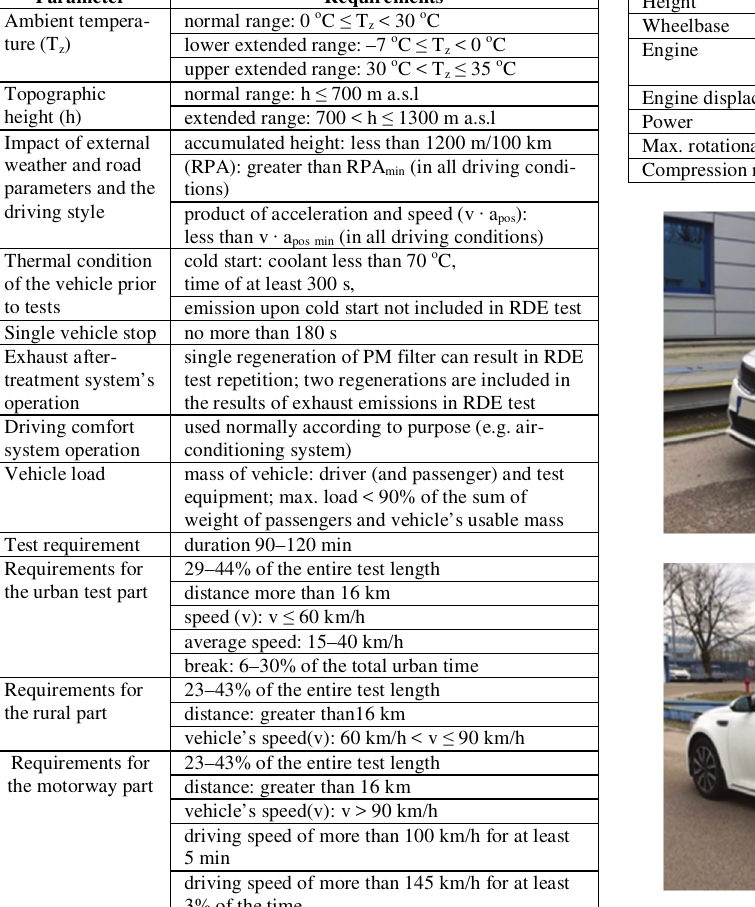
Fig. 5. Vehicle used for tests –